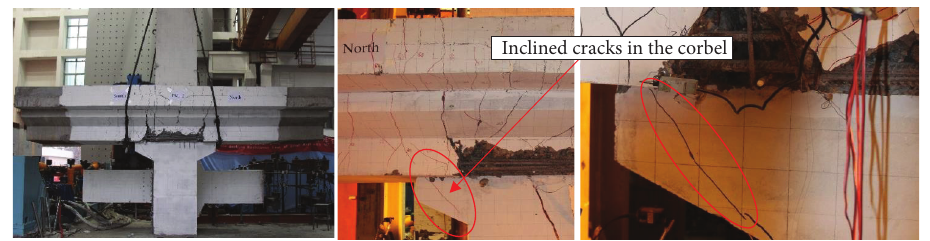
Figure 6: Distribution of cracks of precast joint (PMJ). Table 2: Feature point values of test results.